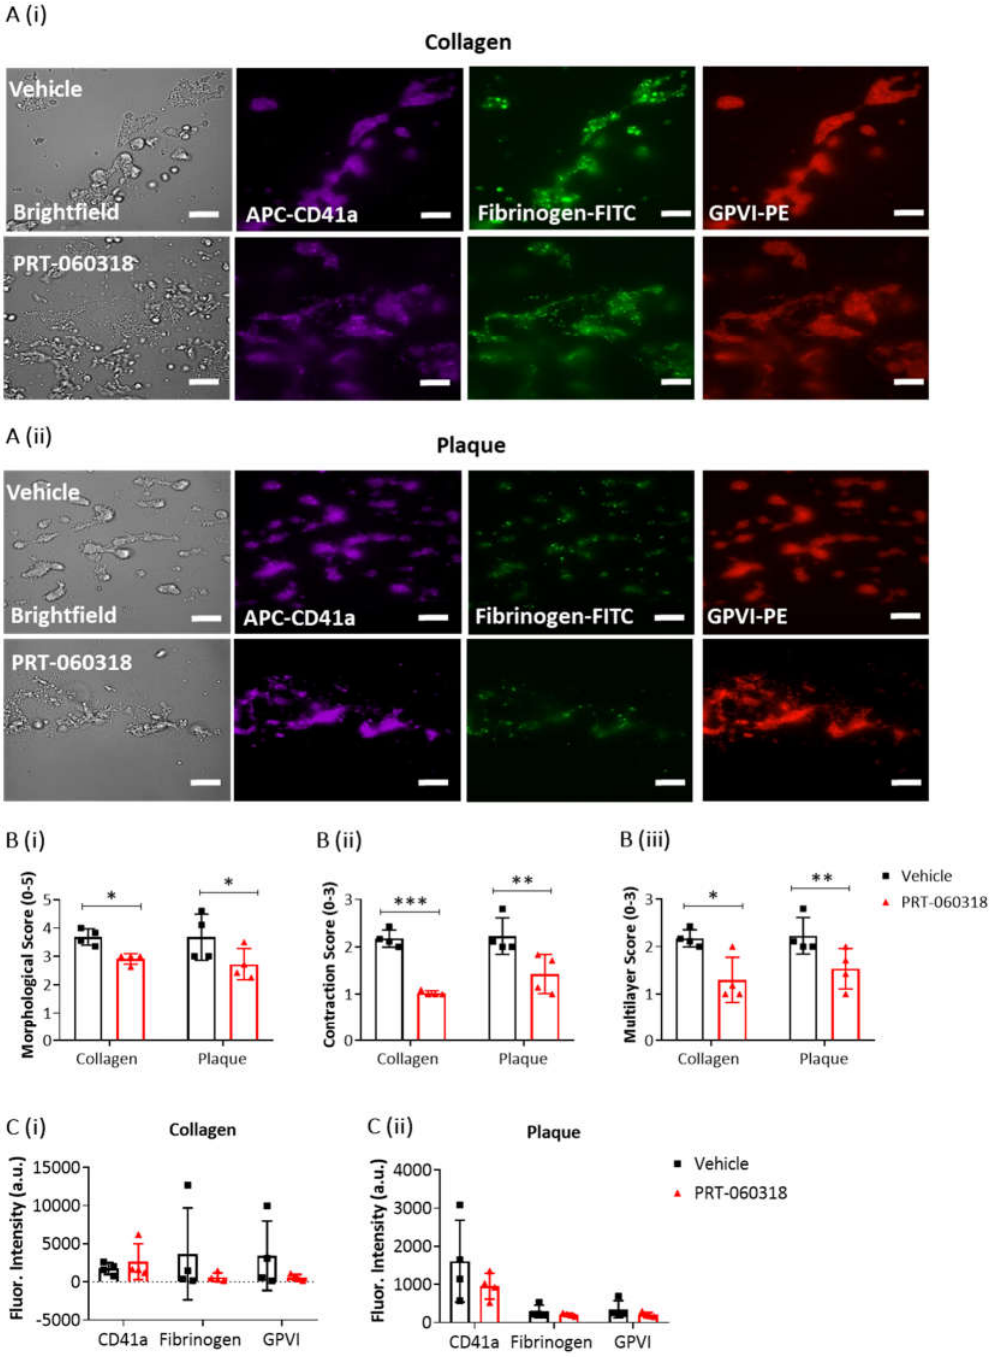
Figure 3. Platelet activation imaging of thrombi postperfused under condition of Syk inhibition. Recalcified blood samples labelled with APC-αCD41a mAb (purple), FITC-fibrinogen (green) and PE-αGPVI mAb (red) was perfused for 7 min over immobilised collagen or plaque material at room temperature and arterial shear rate (1000 s −1 ). Post-perfusion for 3 min was with rinse buffer con- taining vehicle (DMSO) or Syk inhibitor PRT-060318 (10 µM). ( A ) Representative microscopic im- ages, showing remaining aggregates on collagen ( Ai ) or plaque ( Aii ) after 3 min of post-perfusion with vehicle or PRT-060318 ( n = 4 donors). (B ) Graphs showing scores of thrombus morphology ( Bi ), thrombus contraction ( Bii ) and thrombus multilayer ( Biii ) [16]. ( C ) Graphs of fluorescence intensity (arbitrary units, a.u.) of platelet aggregates on collagen ( Ci ) or plaque material ( Cii ) fixed after 3 min